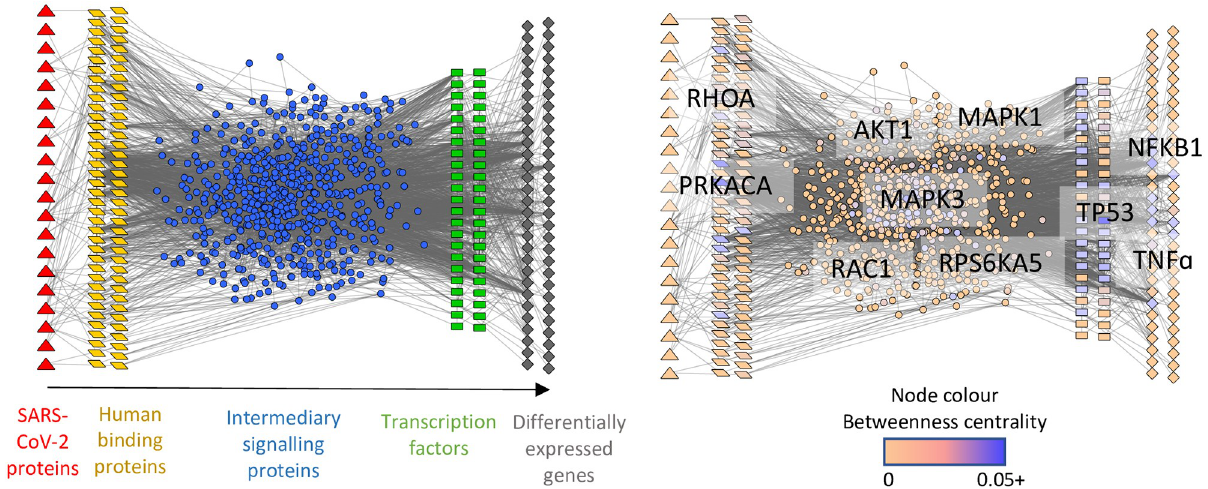
Fig 2. Causal network of SARS-CoV-2-infected NHBE cells. A) Signalling flows from left to right: SARS-CoV-2 proteins/protein fragments (red triangles), human binding proteins (yellow parallelograms), intermediary signalling proteins (blue circles), transcription factors (green rectangles) and differentially expressed genes (grey rhombuses). Where a human protein/gene is acting in multiple layers of the network, it is only visualised once based on the following priority: DEGs, binding proteins, TFs, signalling proteins. B) Results of betweenness centrality analysis, which measures the global importance of nodes (molecules) in the network. Nodes coloured based on their betweenness centrality parameter, with the gene names of the 10 highest scoring (most central) nodes overlaid. DEGs have log2 fold change � |0.5| and adjusted p value � 0.05.